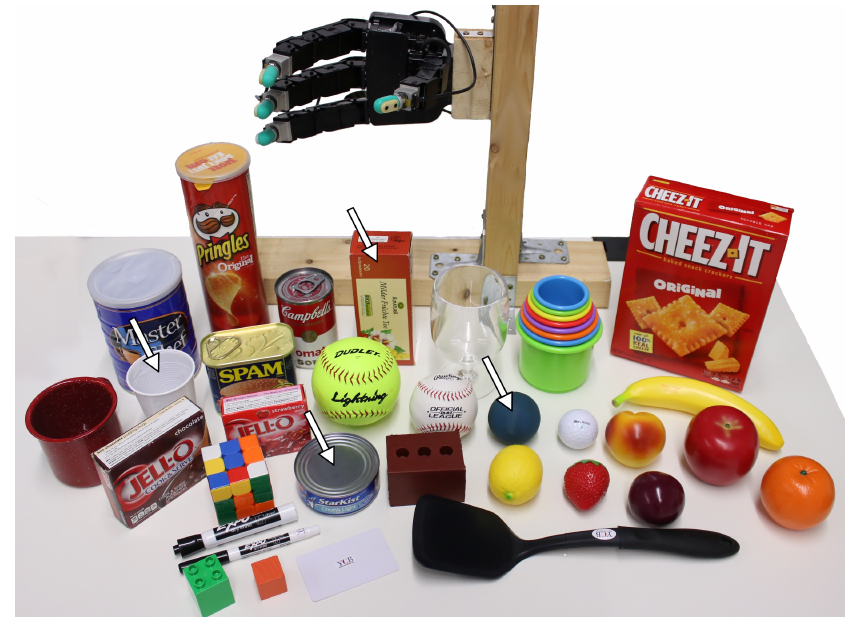
Figure 2. Test objects . Most of the objects were from the YCB object set [38] where only the tea box and the white plastic cup are not in the original set. The training set (indicated by the white arrows) included 4 objects only: a tuna can, a plastic cup, a ball, and a tea